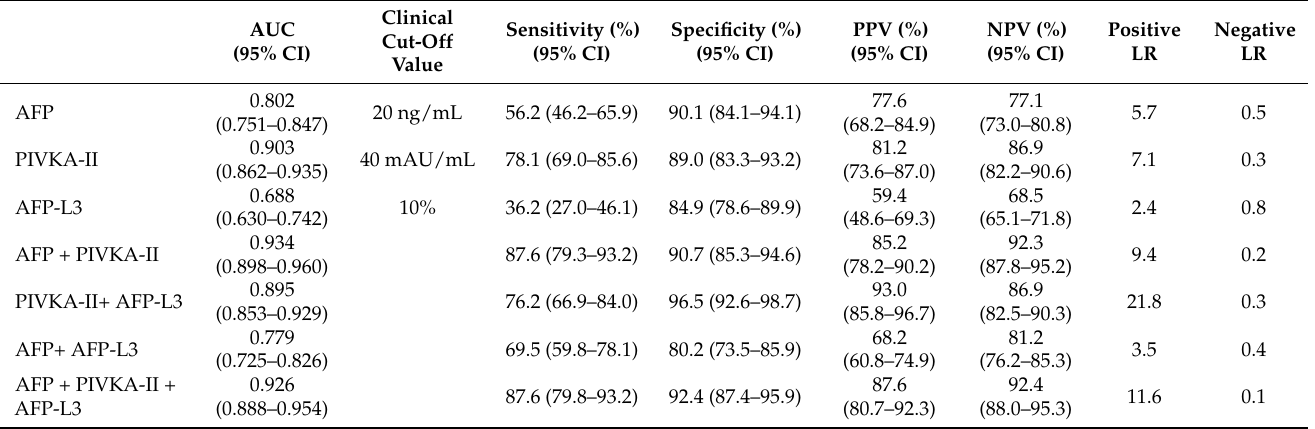
Table 2. Three serum biomarkers for detection of HCV-HCC.